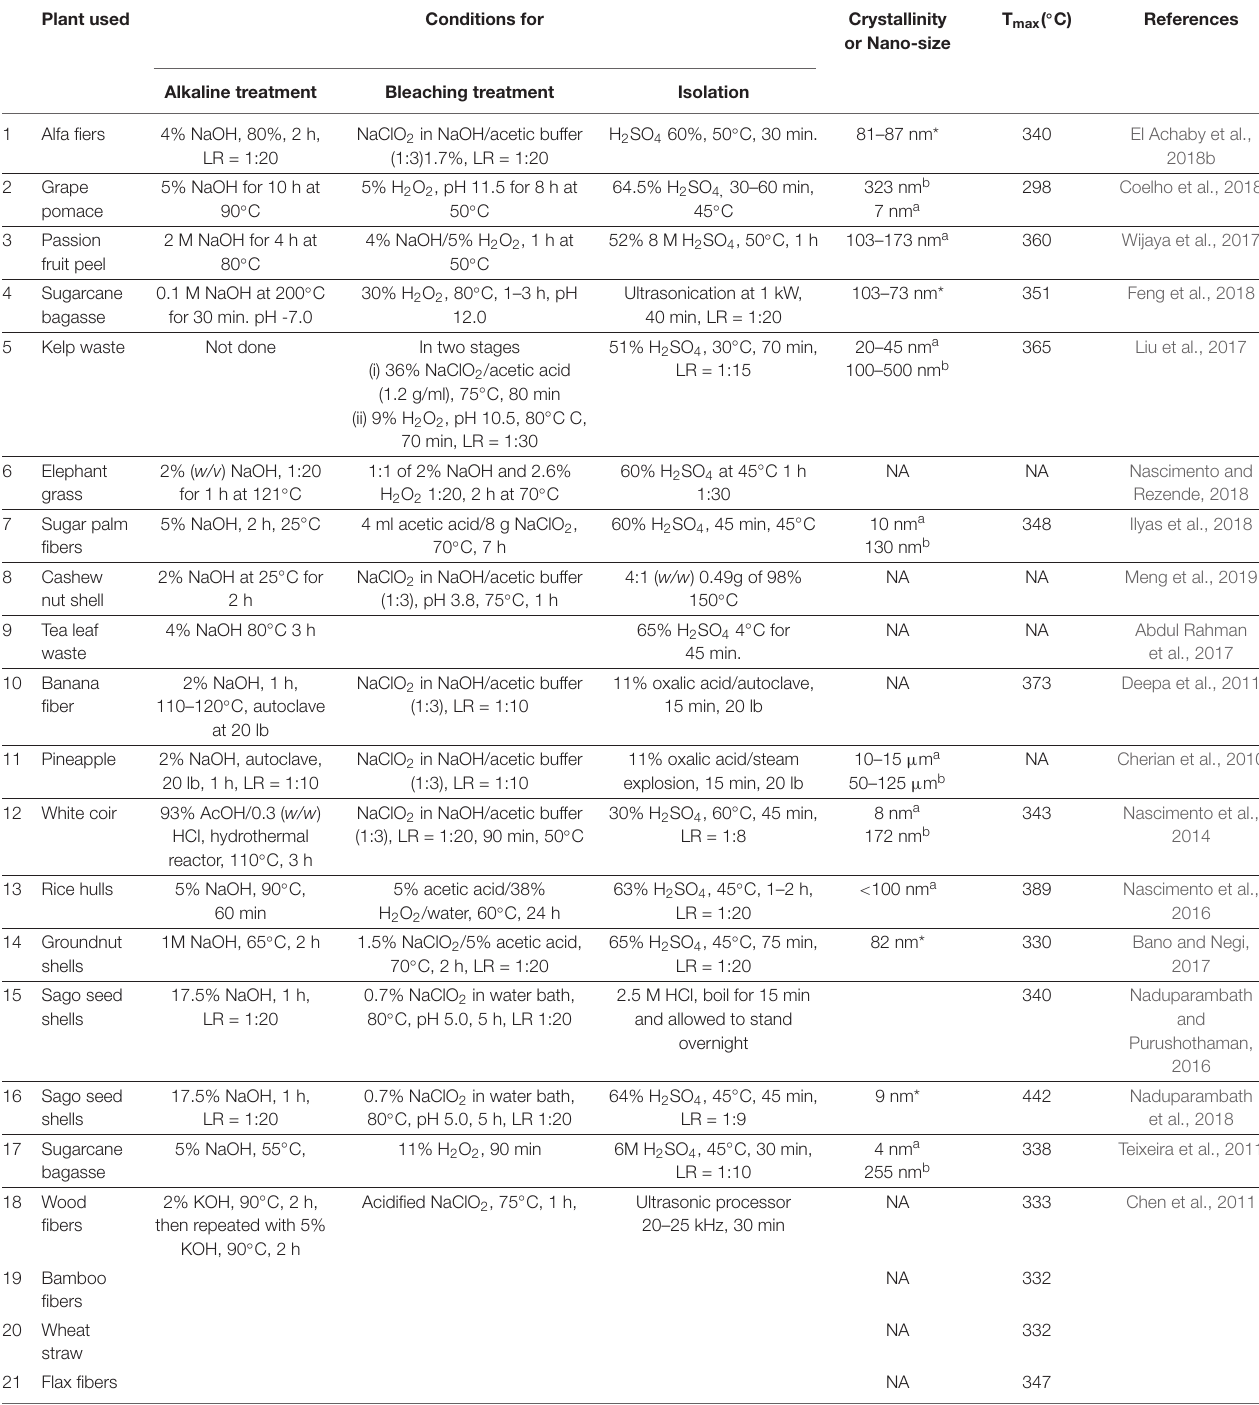
TABLE 3 | Processing conditions for the extraction of nanocellulose from selected literatures. Plant used Conditions for Crystallinity